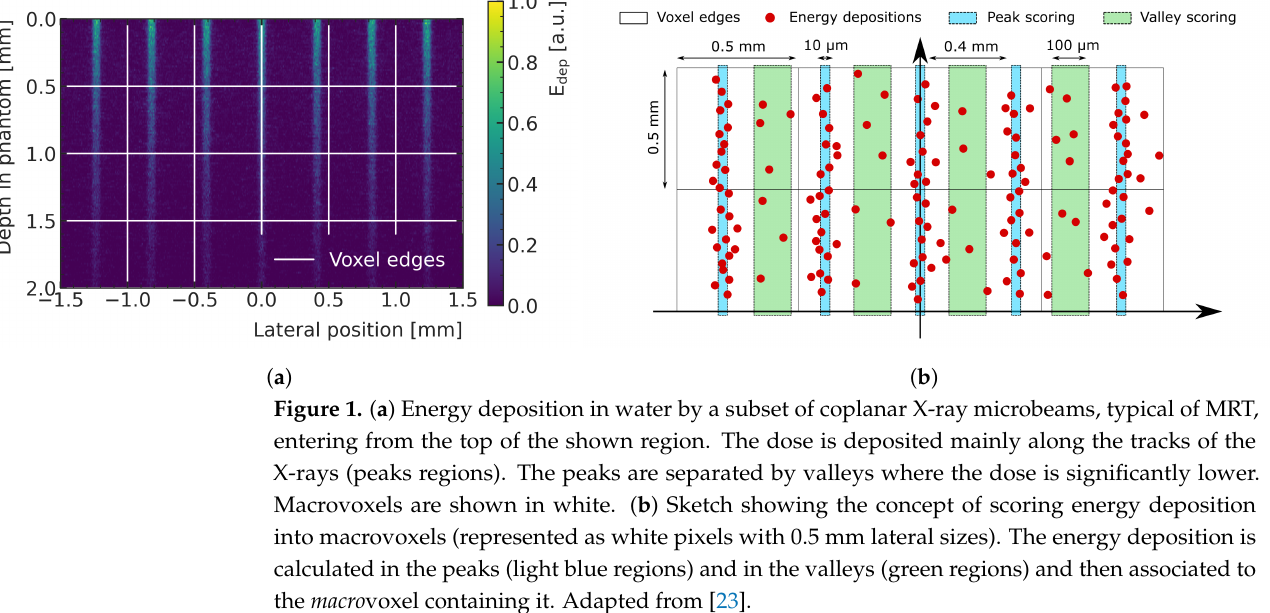
Figure 1. ( a ) Energy deposition in water by a subset of coplanar X-ray microbeams, typical of MRT, entering from the top of the shown region. The dose is deposited mainly along the tracks of the X-rays (peaks regions). The peaks are separated by valleys where the dose is significantly lower. Macrovoxels are shown in white. ( b ) Sketch showing the concept of scoring energy deposition into macrovoxels (represented as white pixels with 0.5 mm lateral sizes). The energy deposition is calculated in the peaks (light blue regions) and in the valleys (green regions) and then associated to the macro voxel containing it. Adapted from [23].